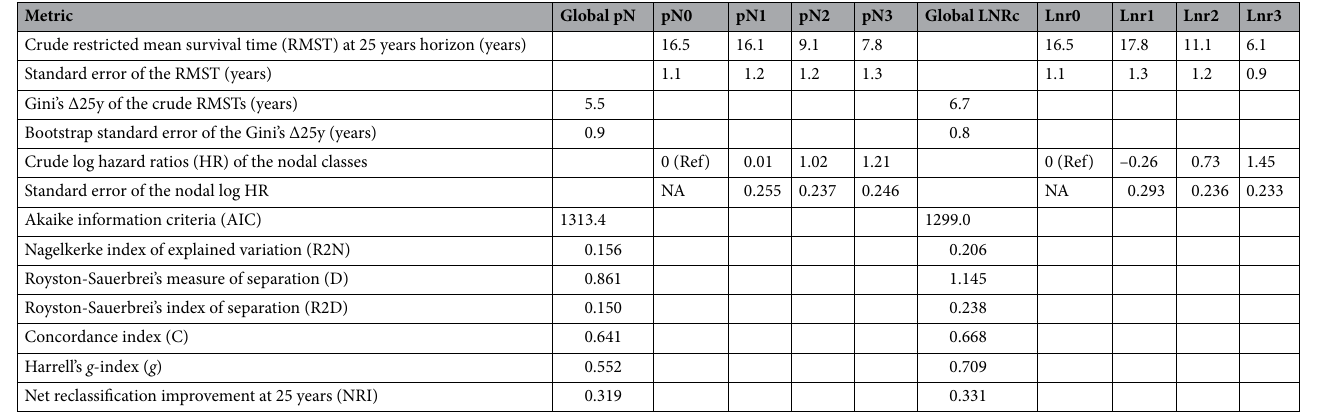
Table 2. Univariate metrics of the nodal quanta classes.